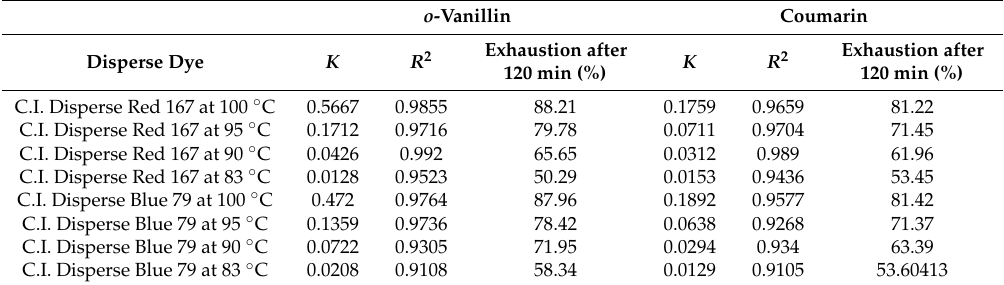
Table 5. Absorption rate constant (K), correlation coefficient (R 2 ) and exhaustion after 120 min (%) for the kinetics of dyeing of polyester with disperse dyes in the presence of o -vanillin or coumarin